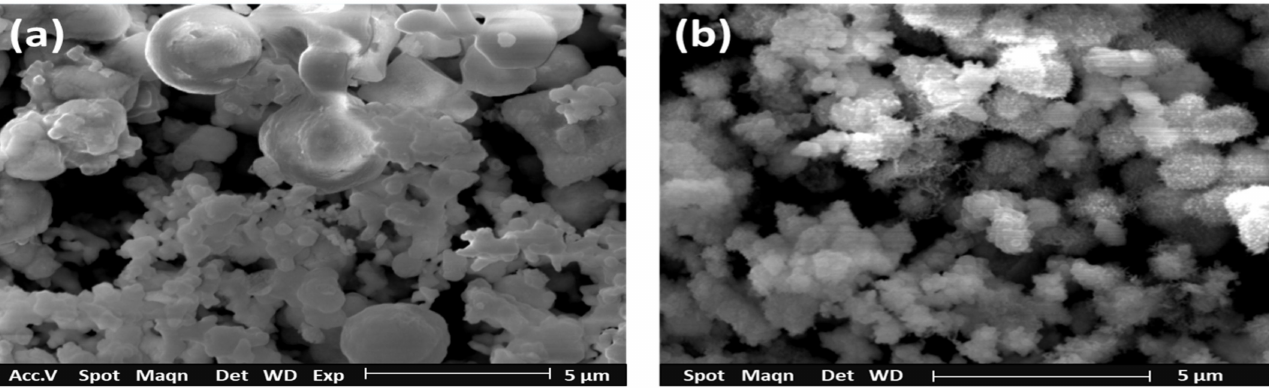
Figure 3. SEM micrographs of NiS nanostructures at: ( a ) 400 ◦ C; ( b ) 450 ◦